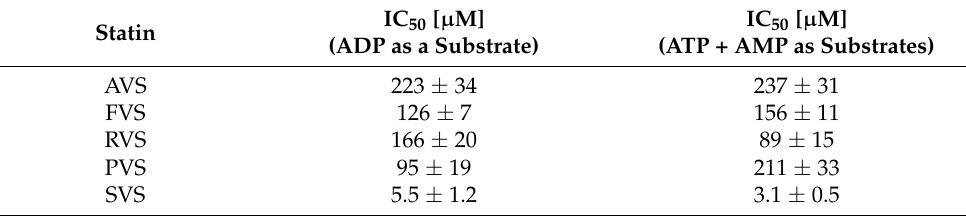
Table 2. IC 50 values of statins determined from hAK1 inhibition studies at 37 ◦ C.